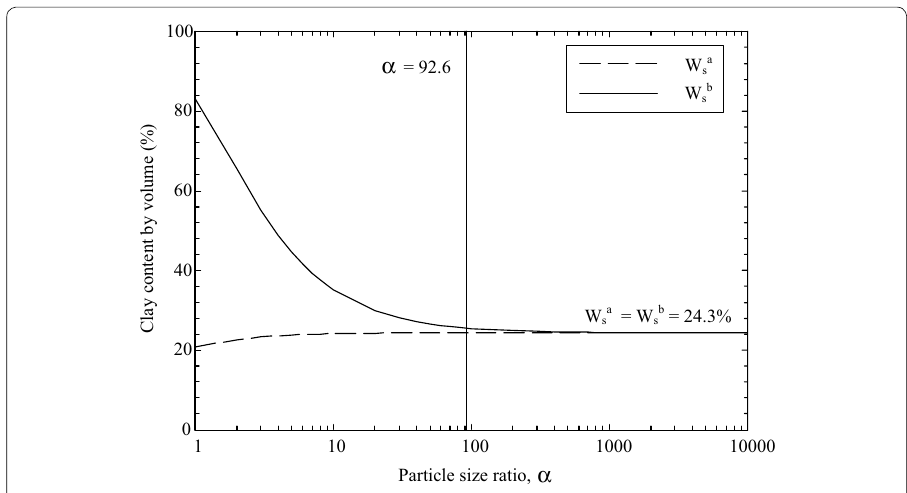
Fig. 11 The variation of W sa and W sb with particle size ratio (modified from Ueda et al.